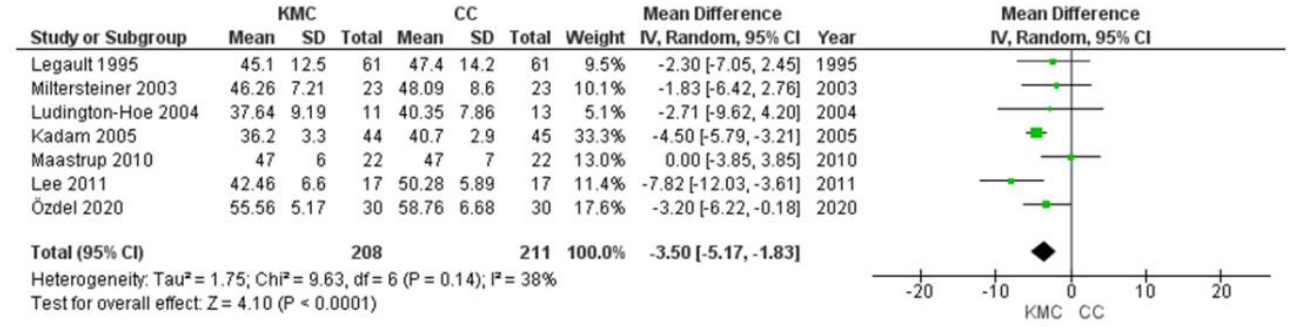
Figure 5. Forest plots for effects of KMC compared with conventional care on heart rate and respiratory rate (breaths/min).